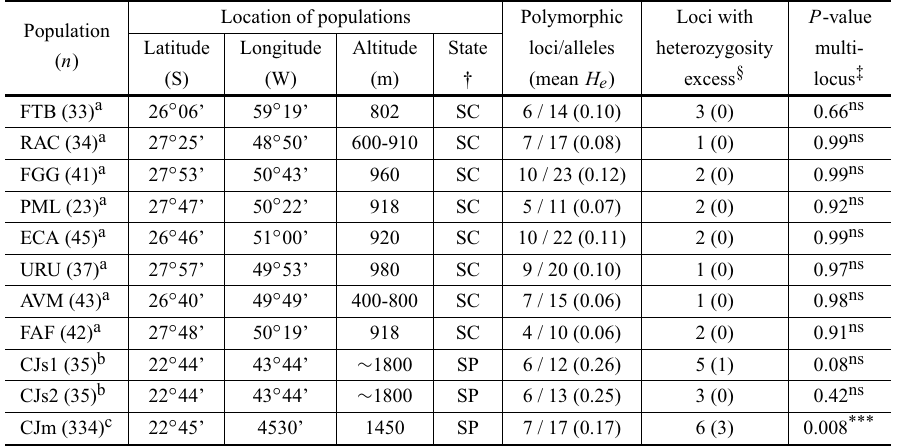
Geographic location of populations and summary of the analysis of heterozygosity excess based on coalescent simulations of isozyme data. Statistically significant values are highlighted in